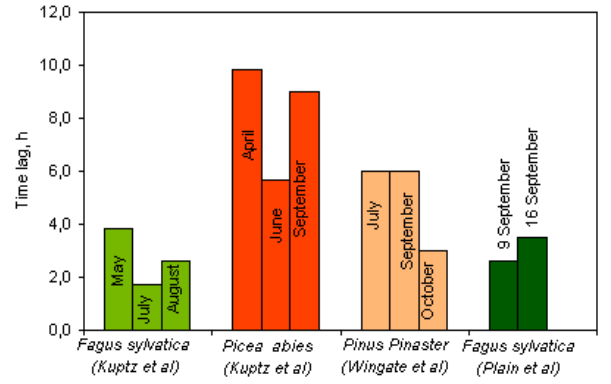
Fig. 2. Seasonal changes in time lag measured by tracing variations in δ 13 C at natural abundance level (Wingate et al., 2010; Kuptz et al., 2011a) or after 13 CO 2 pulse-labeling (Plain et al., 2009) in soil respiration and trunk respiration (at 1m height; Kuptz et al., 2011a). Average values were calculated based on monthly ranges reported in Wingate et al.